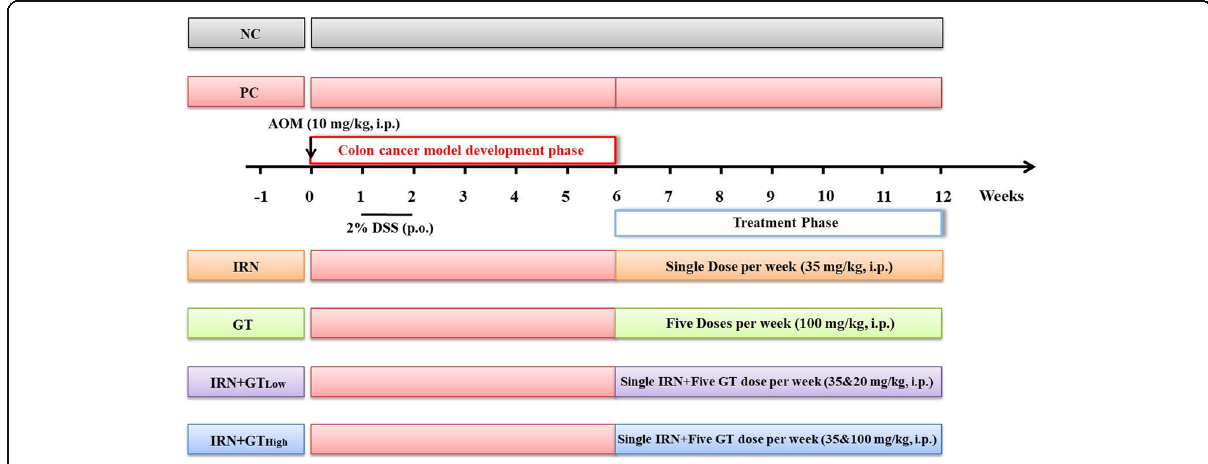
Fig. 1 Experimental design describing the groups, dose, route of administration, and treatment